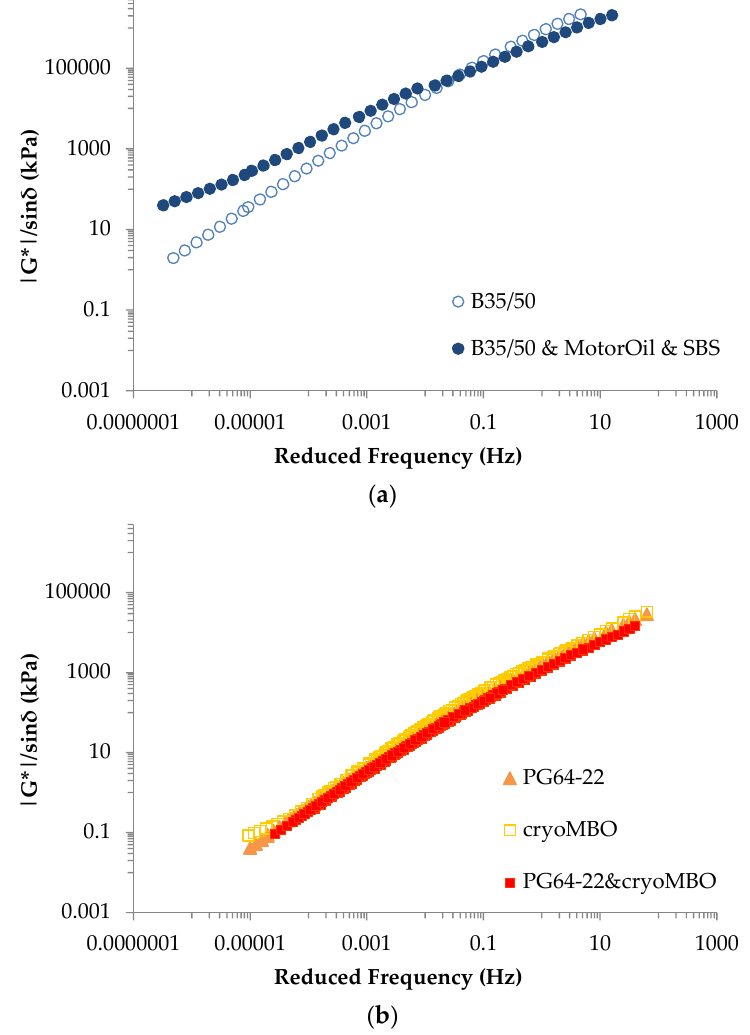
Figure 2. Stiffness master curves (T ref = 20 °C) results of: ( a ) bitumen B35/50 and modified asphalt binder B35/50 & MotorOil & SBS; ( b ) CryoMBO, bitumen PG64 ‐ 22 and modified asphalt binder PG64 ‐ 22 & cryoMBO (adapted from Peralta et al. [6], @ AAPT, 2014). Table 1. High temperature continuous performance grade of conventional bitumens (B35/50 and PG 64 ‐ 22), rubber modified bio ‐ oil (CryoMBO) and modified asphalt binders (B35/50 & MotorOil & SBS and PG64 ‐ 22 & cryoMBO).